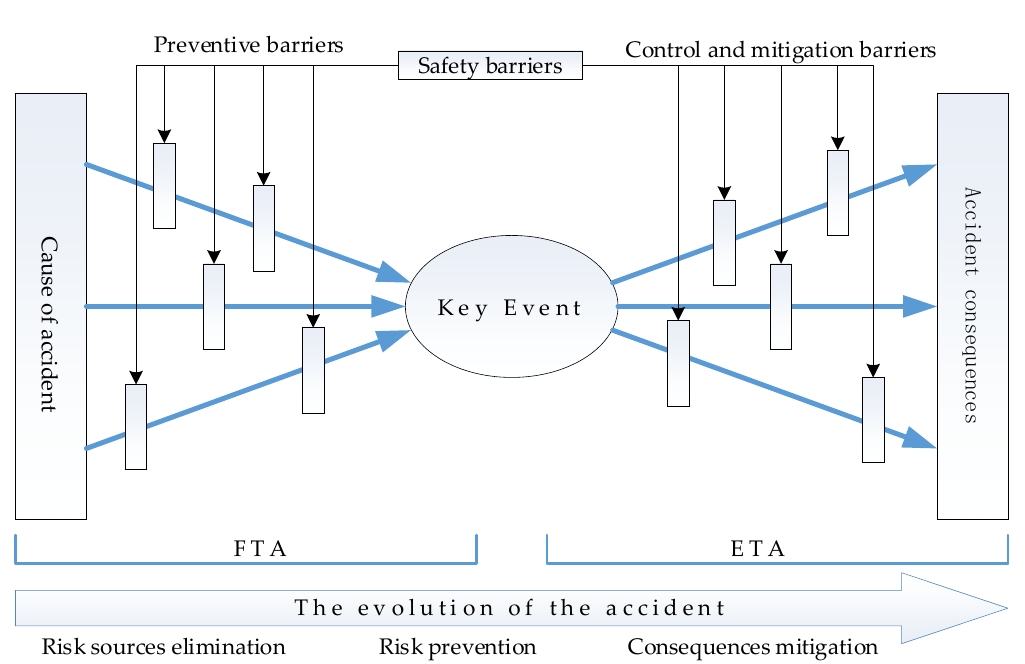
Figure 2. The principle of accident risk prevention and control based on the BT method.